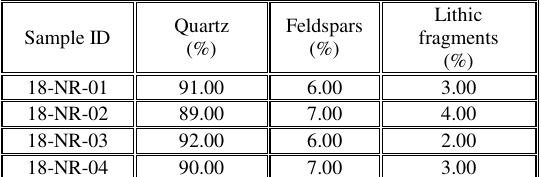
Fig.7: Source Rock Effect On Nari Sandstone, Modified After Suttner et. al . [15] Diagram Table 3: The Recalculated Modal Composition of Quartz, Feldspar and Lithic Fragments of Nari Sandstone